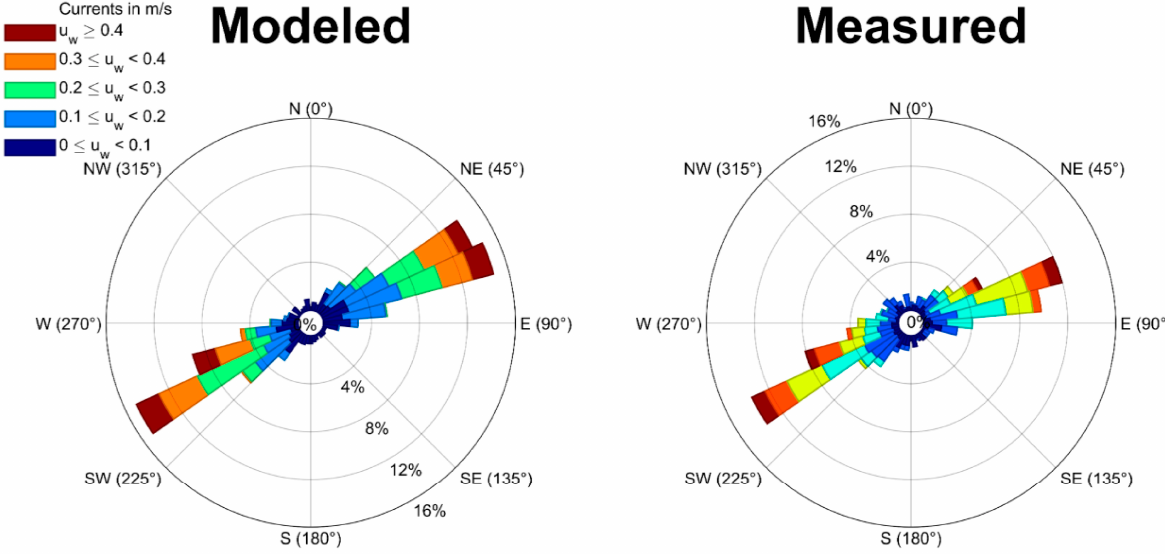
Figure 7. Currents roses comparison for simulations and measurements for the validation period.